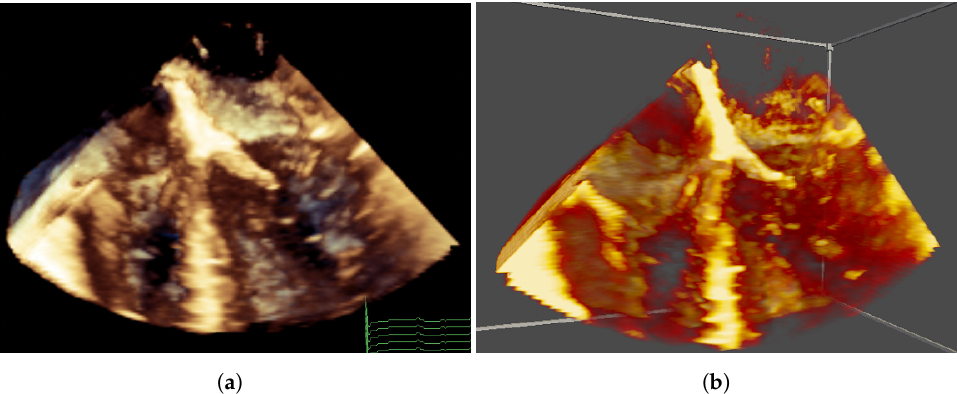
Figure 5. Comparison of image quality between QLAB and the VR system. ( a ) QLAB image with colour depth cueing, where closer tissues are brown and farther tissue are blue. ( b ) VR image with a similar colour map, but without colour depth cueing. Table 1. Preference comparison of image quality between the proposed VR system and QLAB. A χ 2 test shows that participants significantly prefer the VR system overall, and also specifically in terms of depth and